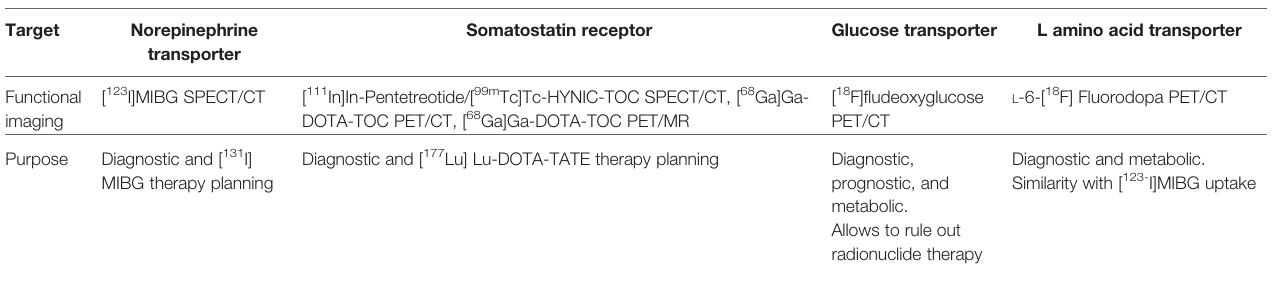
TABLE 1 | Target and purpose of the nuclear medicine scans used in this